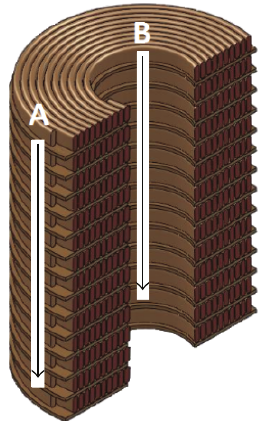
Figure 5: Schematic figure of a transformer winding showing points A and B where paper samples were taken for DP evaluation.